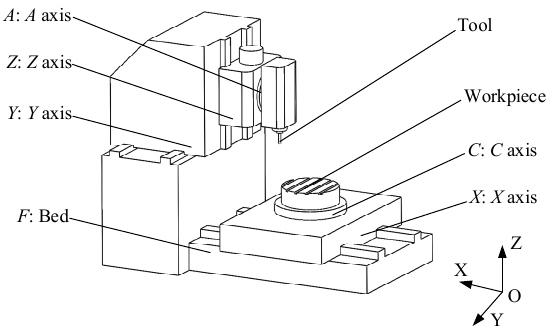
Figure 1. RTTTR-type five-axis machine tool structure diagram.